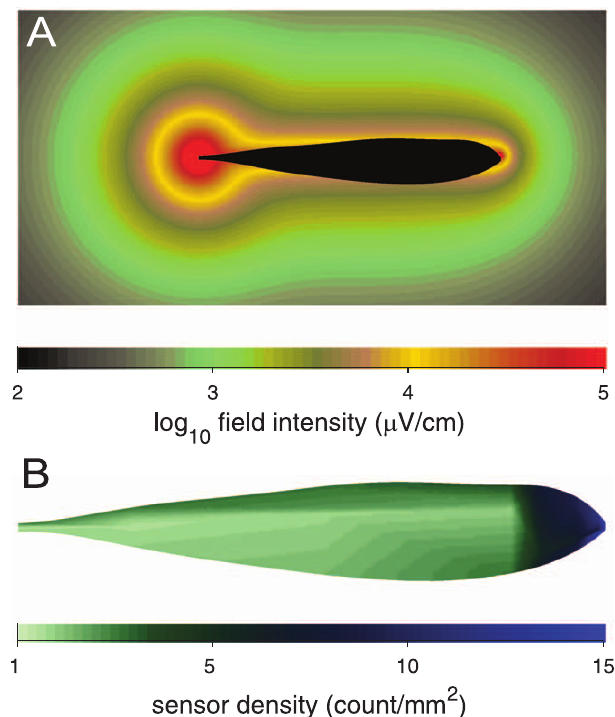
Figure 1. Spatial Distributions in the Active Electrosensory System of A. albifrons (A) Magnitude of the self-generated electric field in water of 35- l S/cm conductivity from an empirically validated computational model [41]. (B) Density of tuberous (active) electroreceptor sense organs (interpolated from measurements in [44]). The fish is shown without fins because there are no electroreceptors on the fins.